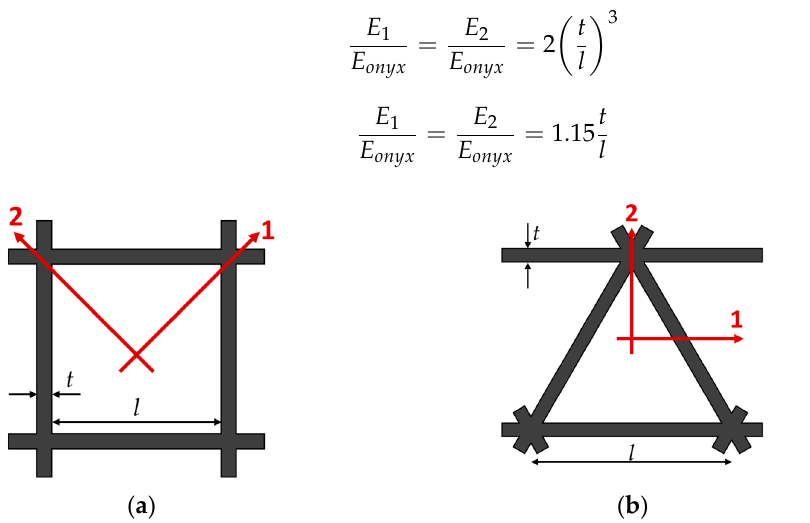
Figure 6. Core geometries for the analytical evaluations: ( a ) Rectangular and ( b ) Triangular.